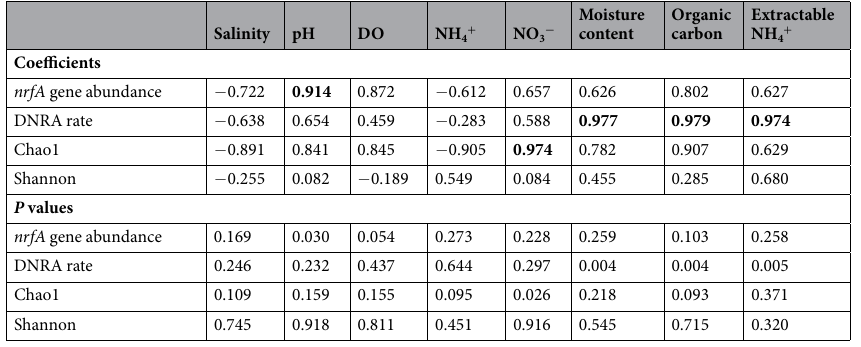
Table 1. Pearson’s correlation coefficients of DNRA rate, nrfA gene abundance, diversity index and environmental parameters (n = 5 for nrfA gene abundance and DNRA rate; n = 4 for Chao1 and Shannon).